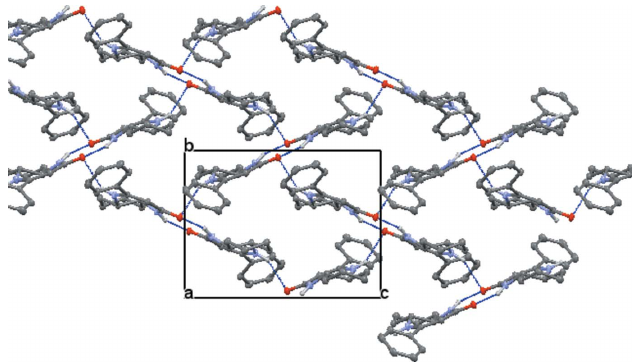
Figure 2 Packing viewed along the a -axis direction. N—H (cid:2)(cid:2)(cid:2) O hydrogen bonds are depicted by dashed lines.